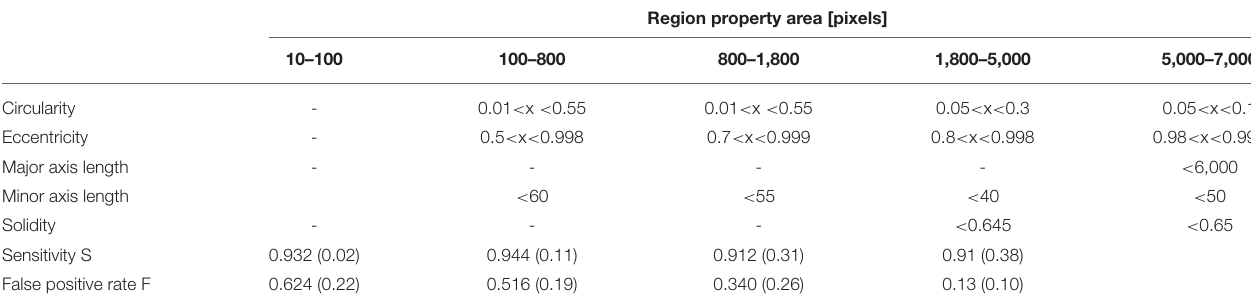
TABLE 3 | Size classes for particle detection based on the pixels of the area region